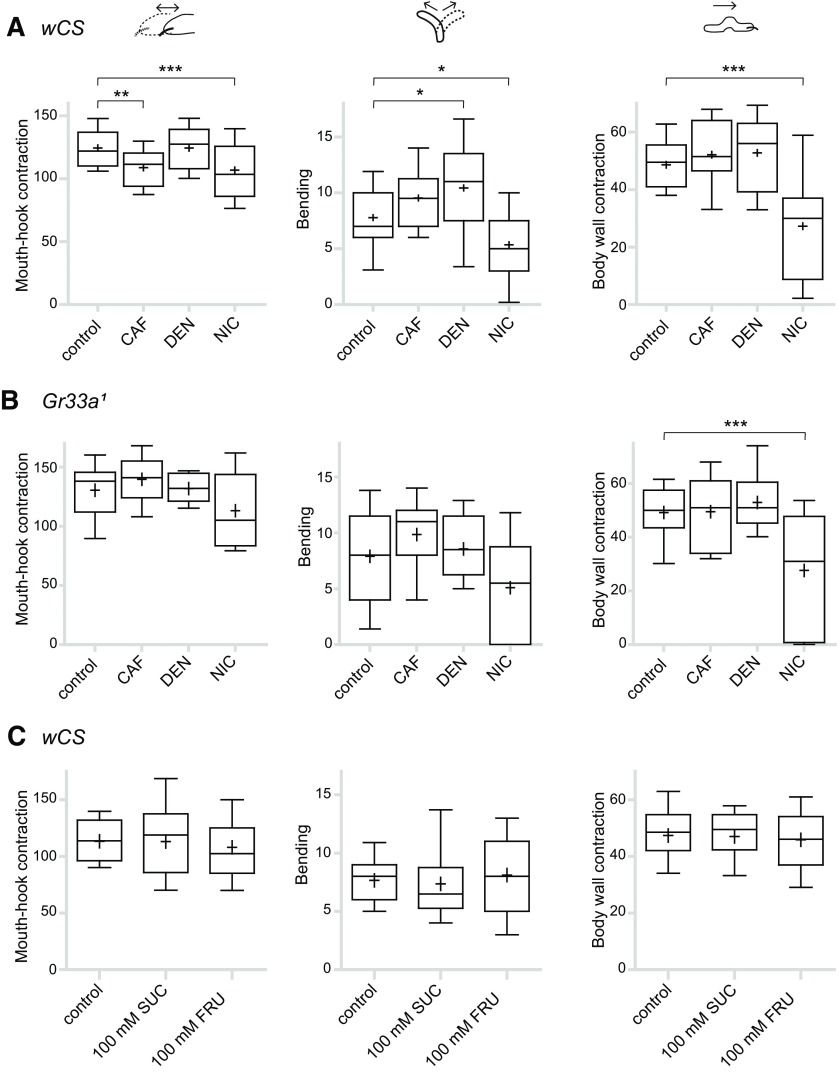
Measurement of larval behavioral responses to given tastants: mouth-hook contractions (left), bending (middle), and body wall contractions (right). Behavioral responses during 1 min for larvae placed on agarose plates containing the indicated tastants, compared with larvae placed on agarose-only control plates. A, Results for wCS larvae. For each data point, 16 < n < 40; *p < 0.05, **p < 0.01, ***p < 0.001 versus control, one-way ANOVA followed by Dunnett’s multiple comparison test. B, Results for Gr33a1 larvae. For each data point, 16 < n < 40; ***p < 0.001 versus control, one-way ANOVA followed by Dunnett’s multiple comparison test. C, Behavioral responses of wCS larvae to the indicated sugars and control. For each data point, 16 < n < 40.